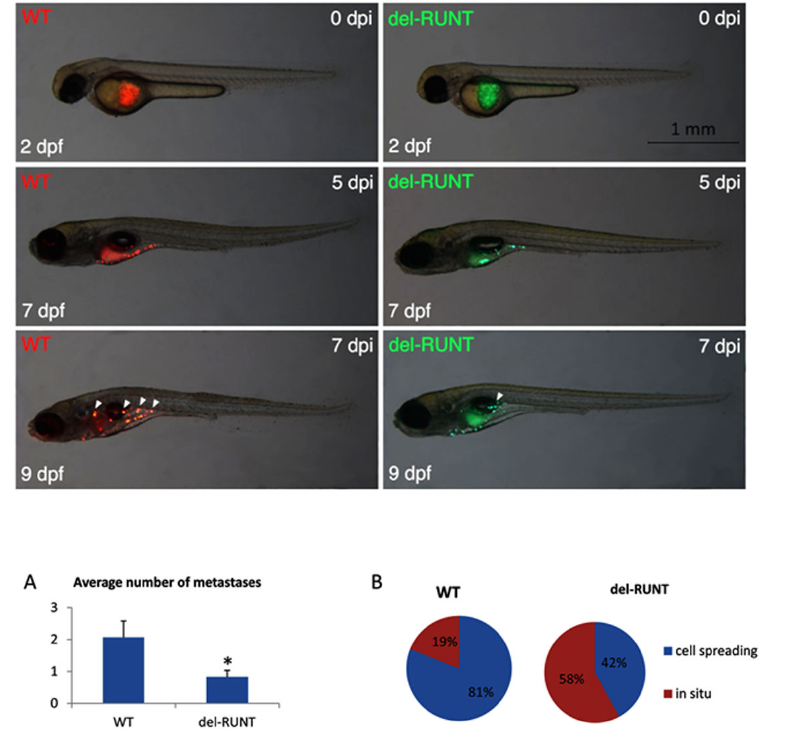
Figure 9. Differential migratory ability of wild-type and del-RUNT cells in zebrafish xeno-transplants. Representative images show wild-type (WT, stained in red) and del-RUNT (del-RUNT, stained in green) cells xeno-transplanted in zebrafish embryos 2 days post fertilization (dpf). At day 0 post injection (dpi), transplanted cells are still located in the yolk. At 5 dpi, cells appear more dispersed in the yolk of 7 dpf larvae. At 7 dpi/9 dpf, initial metastases (indicated by white arrowheads) are detectable in WT and, to a lesser extent, in del-RUNT- transplanted larvae. All views are lateral, anterior to the left. Charts on average number of metastases and cell spreading, calculated at 9 dpf in WT (N:22) and del-Runt (N:12) transplanted zebrafish, are shown in ( A ) and ( B ), respectively. * p <